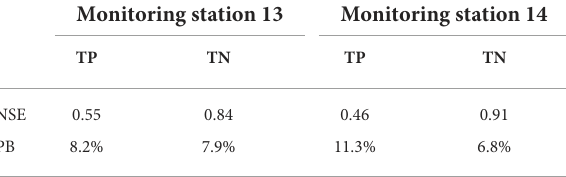
TABLE 1 The NSE and PB at monitoring stations 13 and